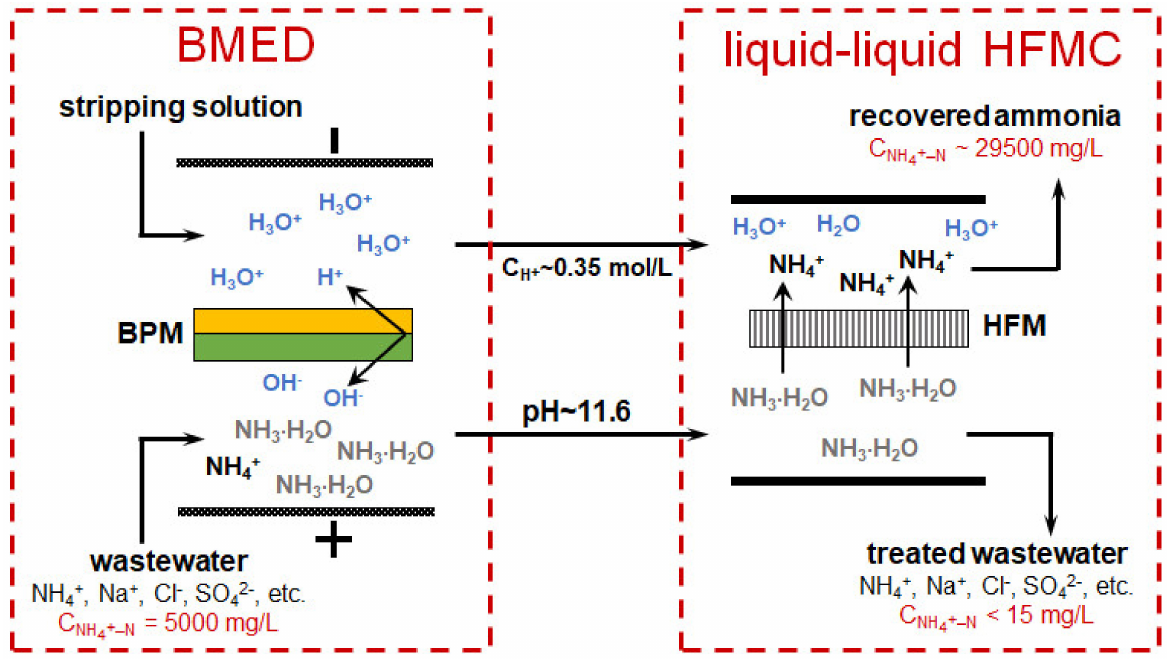
Figure 13. Scheme and details of ion transport in the BMED module for continuous recovery and concentration of N III from wastewater using a combined BMED-liquid-liquid HFMC system. Based on